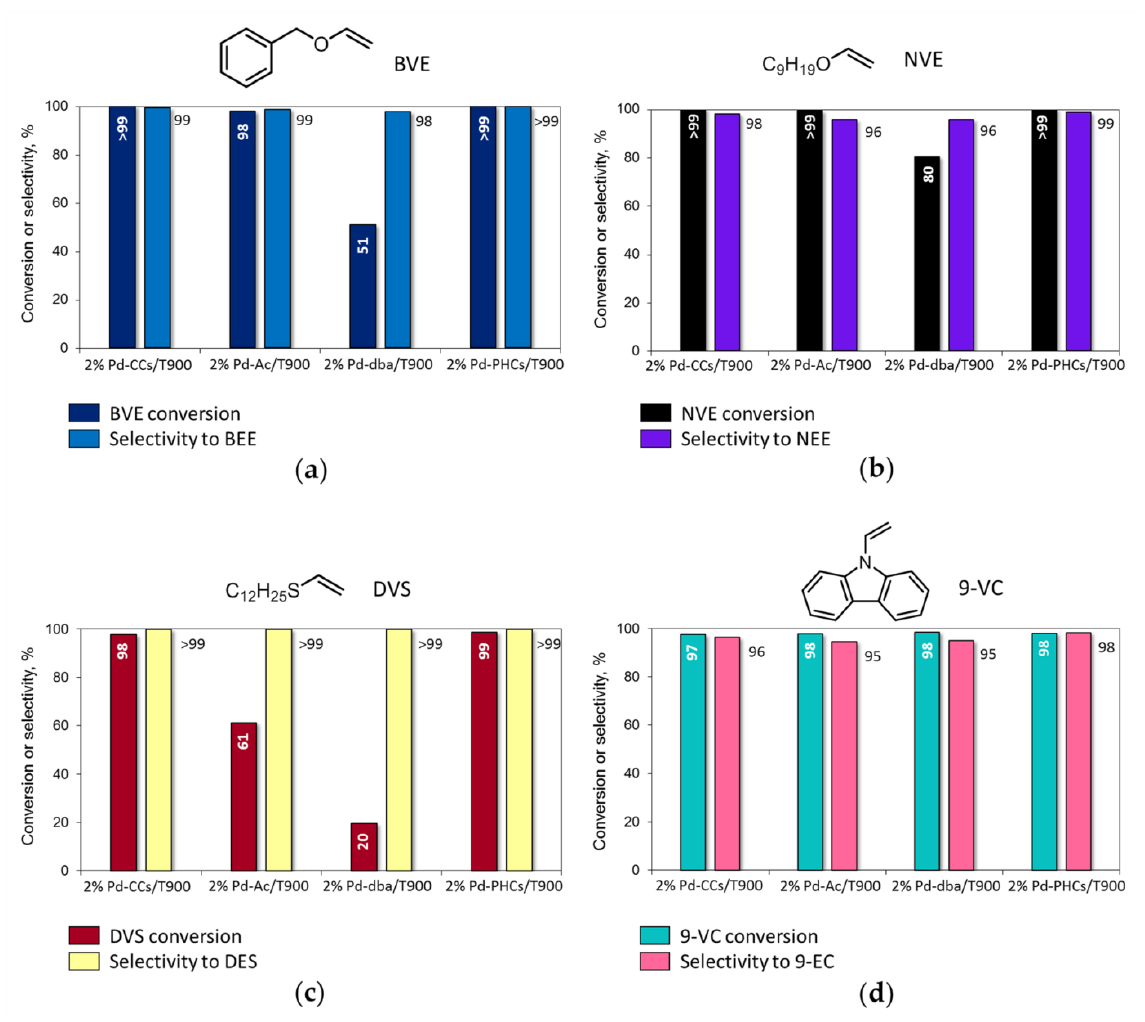
Figure 4. Catalytic performance of 2% Pd/T900 catalysts prepared from different palladium precursors in the liquid-phase hydrogenation of vinyl derivatives: ( a ) BVE; ( b ) NVE; ( c ) DVS; ( d ) 9-VC. Reaction conditions: 50 mg catalyst (9.5 µ mol Pd), 50 mg substrate, 2.0 mL MeOH (benzene for hydrogenation of 9-VC), 295 K, 1.0 MPa H 2 , 2 h. The products were identified by NMR and GC–MS (see Supplementary Materials).